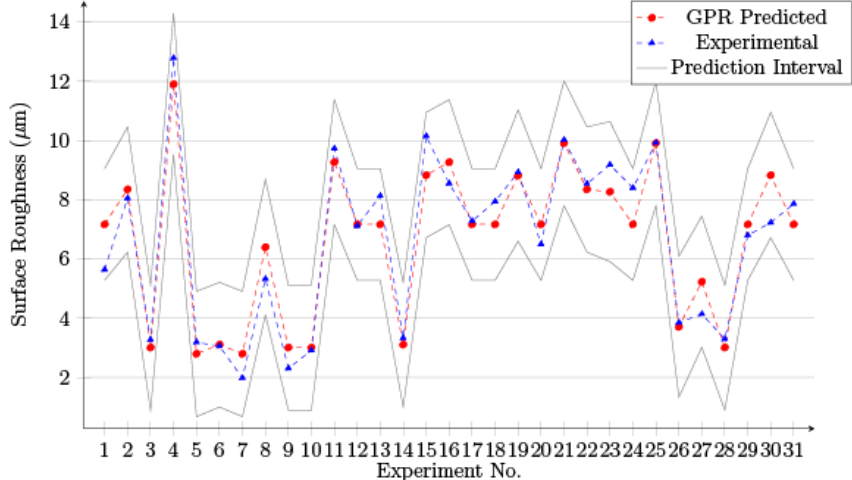
Figure 18. Experimental and GPR predicted values for Ra training data.